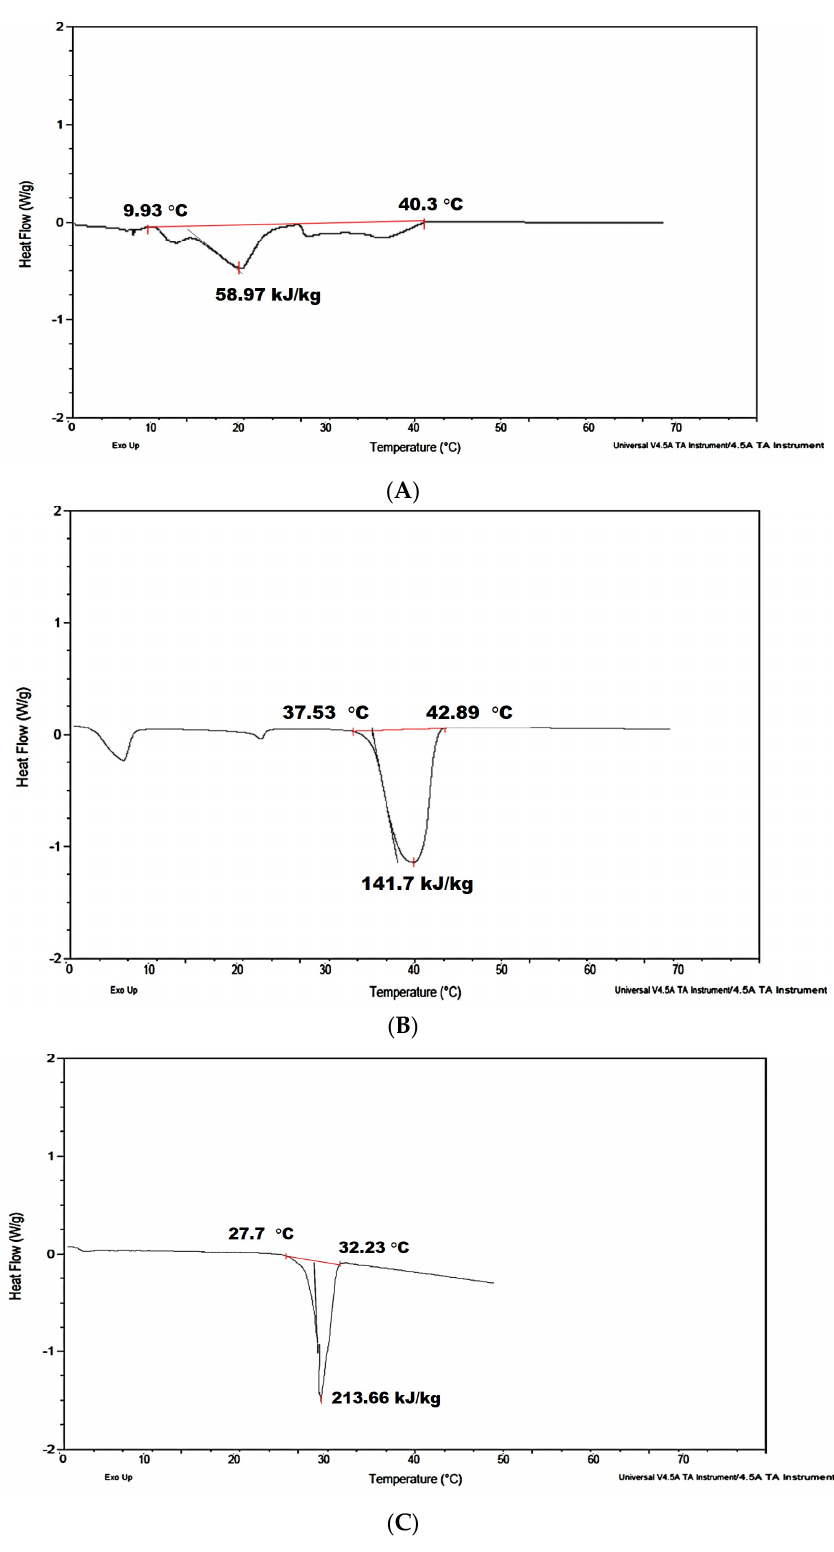
Figure A1. Differential Scanning Calorimetry (DSC) heating curve for ( A ) Milk fat, ( B ) Paraffin and ( C ) Salt.